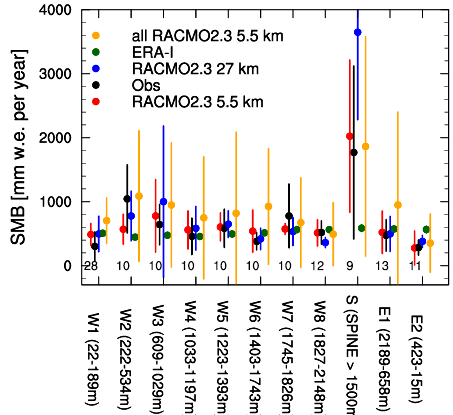
Figure 2. Modelled RACMO2.3 5.5km (red), RACMO2.3 27km (blue), ERA-Interim (green) and observed (black) SMB as a func- tion of 11 elevation bins for all in situ SMB observations. The or- ange dots are the average SMB of all RACMO 5.5km grid points in the elevation bins. The bins are arranged from west to east in three separate classes (WAP (W1–8), the spine (S) and the EAP (E1–2)), using the drainage basin definition from Zwally et al. (2012). Error bars represent 1 standard deviation within the bin and amount of observations in each bin is denoted within the plot. Further details are provided in the text (Sect.